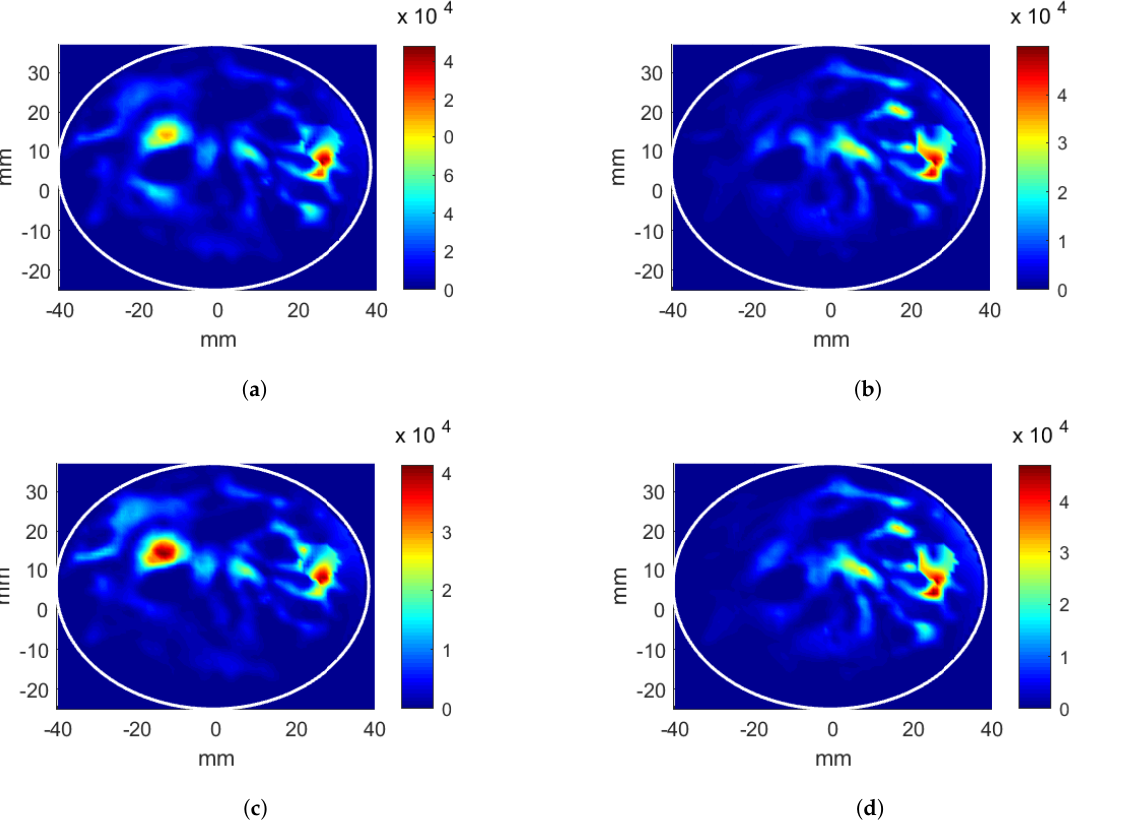
Figure 5. Heating potential (Wm − 3 ) distributions for the linear antenna system and the breast with a tumor at (26, 12, 0) mm position. Excitation parameters obtained from CNN: ( a ) phase- only optimization, ( b ) phase and power optimization. Parameters obtained from look-up table: ( c ) phase-only optimization, ( d ) phase and power